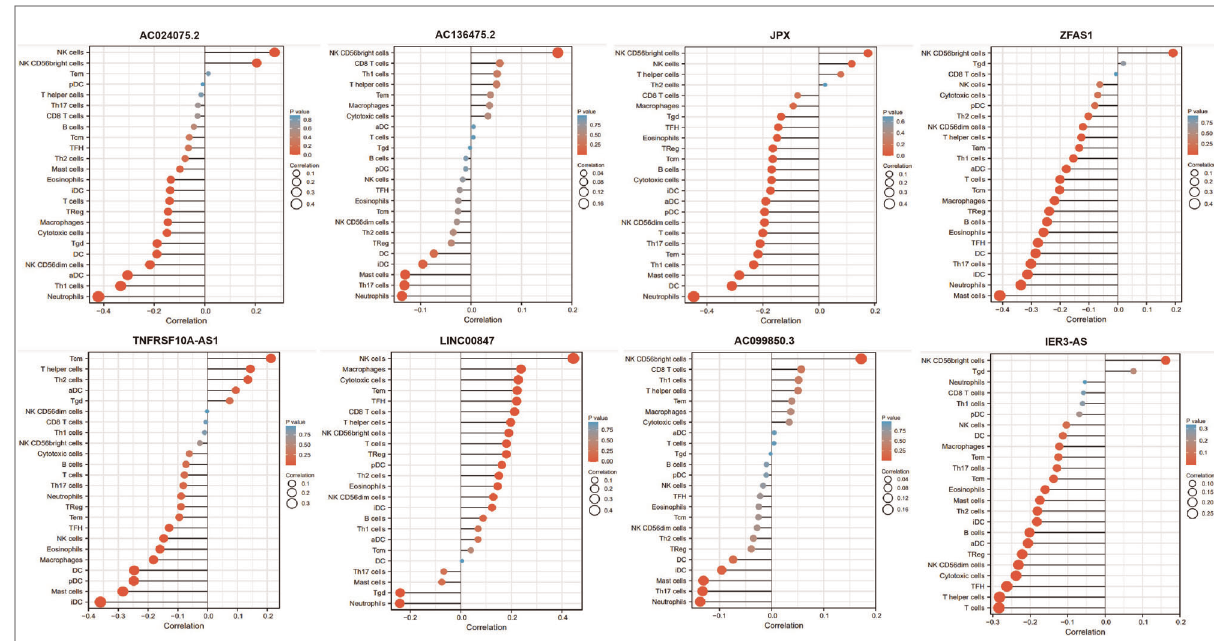
FIGURE 13 Relationship between 8 pyroptosis-related lncRNAs and immune in fi ltration. Lollipop plot shows the correlation between AC136475.2, AC024075.2, JPX, ZFAS1, TNFRSF10A-AS1, LINC00847, AC099850.3 and IER3-AS expression and 24 immune cell subsets in fi ltration. The size of dots indicates the absolute Spearman r